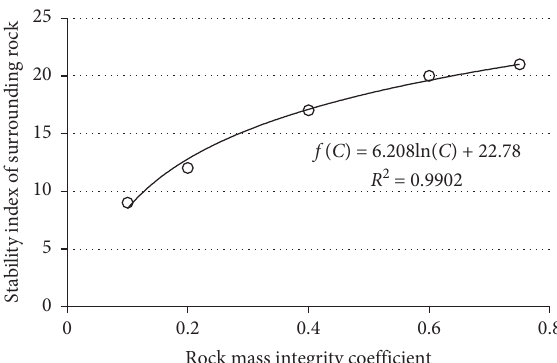
Figure 5: Fitting curve between stability index of surrounding rock and span of tunnel.